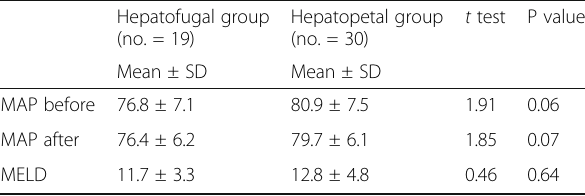
Table 4 Comparison between the studied groups regarding MAP before and after Hepatofugal group Hepatopetal group (no. = 19) (no. = 30)